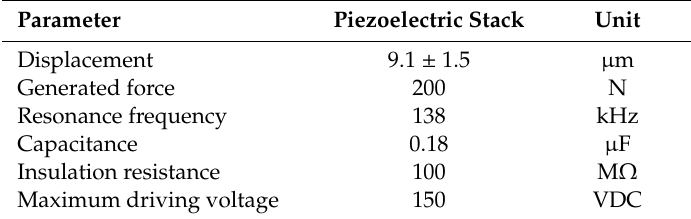
Figure 8. The prototype of the proposed scissoring actuator with a beam tip of 7 mm. Table 2. The performance parameters of the piezoelectric